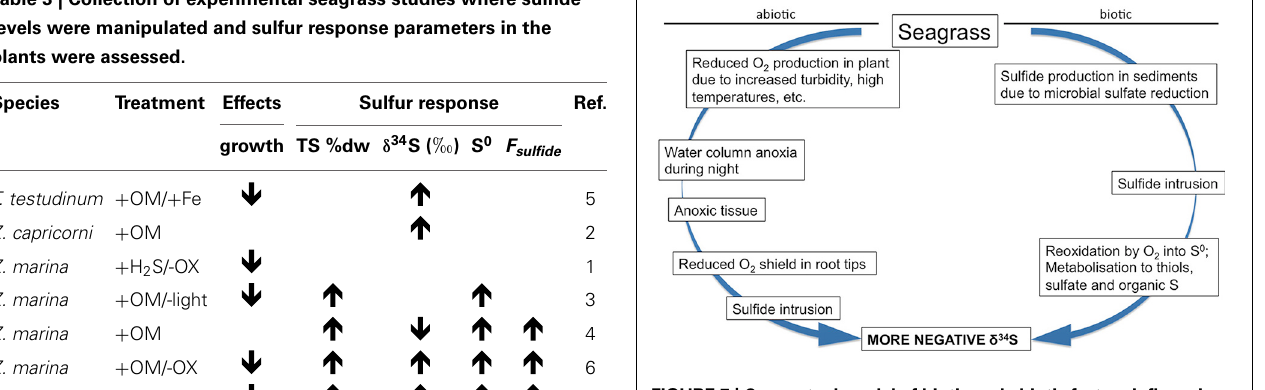
FIGURE 7 | Conceptual model of biotic and abiotic factors influencing the δ 34 S of seagrass